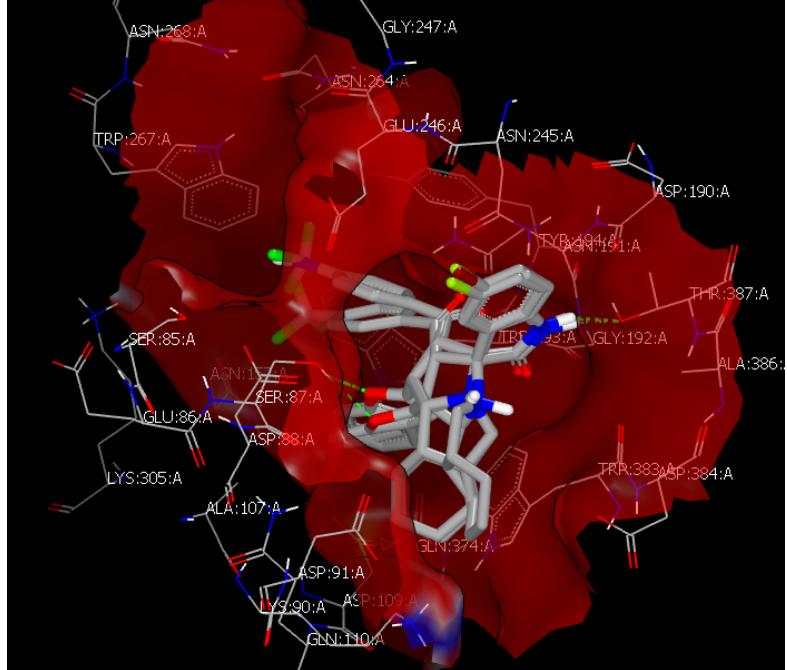
Figure 3. Vida visualization showing how all compounds 5k , 5q , and 5j overlay with each other in transoid form in the receptor cleft.